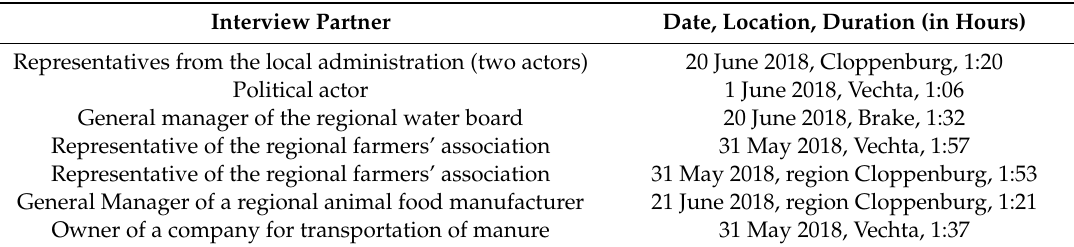
Table 2. List of interview